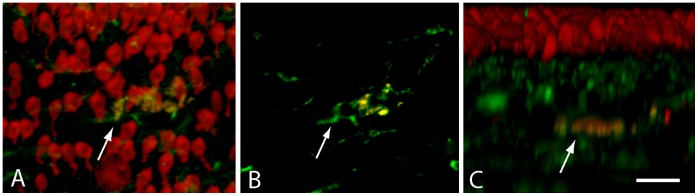
Co-localization of macrophages with hair cell debris.Cochleae were fixed at one day after completion of streptomycin injections (see text) and immunolabeled for KUL01 (green, macrophages) and myosin VIIA (red, hair cells). Specimens contained a small number of cells that were double-labeled for both markers (arrows). Such labeling is suggestive of macrophages having phagocytosed the remains of injured hair cells. Reconstruction of confocal image stacks revealed that such cells were below the sensory epithelium (C). Scale bar = 30 µm.